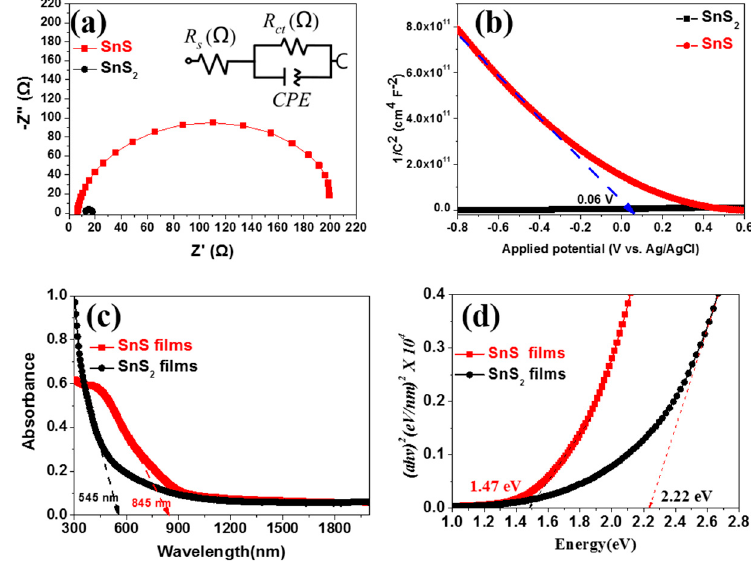
Figure 6. ( a ) Electrochemical impedance spectra (EIS) for SnS thin films at an applied ac potential of (cid:48) and Z” are the real and imaginary parts of impedance, − 0.6 V and SnS 2 thin films is 0.8 V where Z respectively, while the solid lines were fitted by NOVA software using the equivalent circuits; ( b ) Mott–Schottky plots of SnS and SnS 2 thin films at a scan rate of 5 mV/s (CE: Pt); ( c ) UV-Vis absorption spectra as a function of incident photon wavelength; and ( d ) direct bandgap of SnS and SnS 2 thin